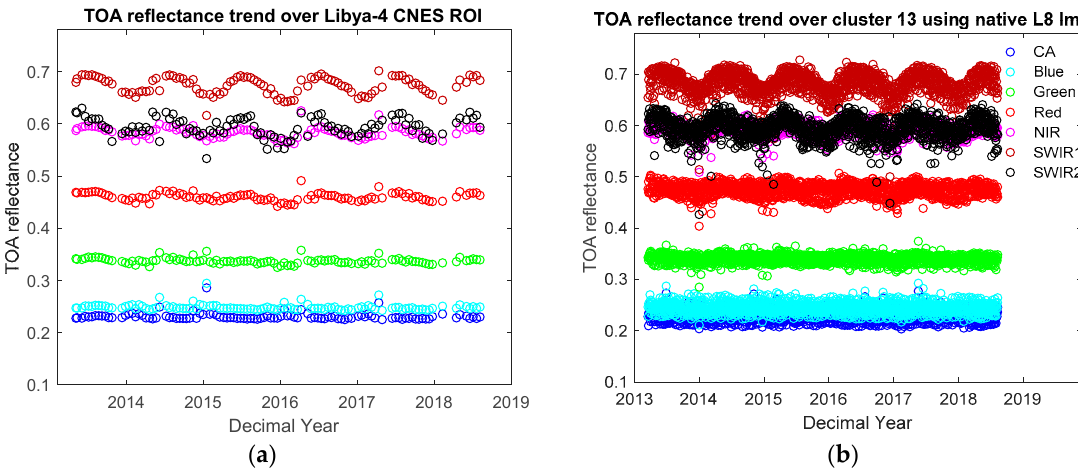
Figure 4. TOA reflectance trend from ( a ) Libya-4 ROI (Left); ( b ) Cluster 13 without any further cloud screening and correction (Right).